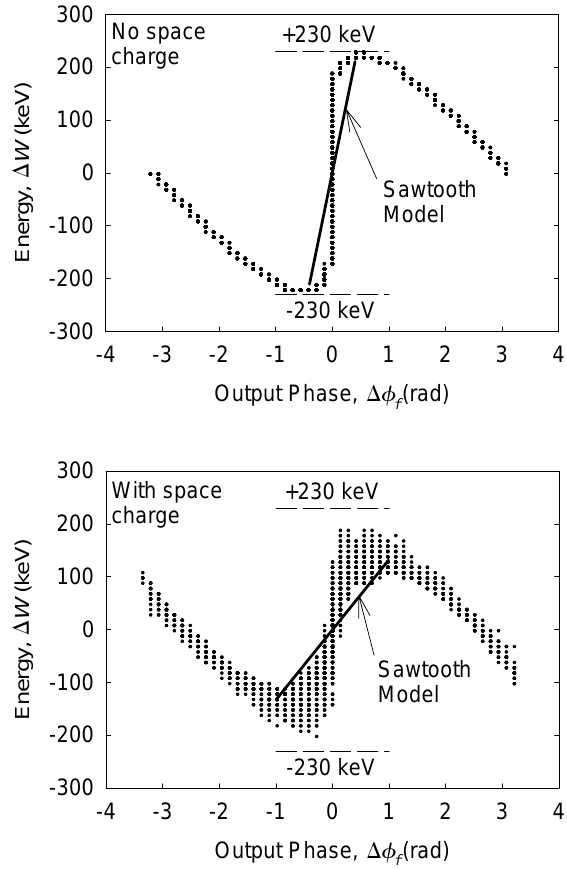
FIG. 4. Phase space diagrams for the analytic and PARMELA results. The initial energy modulation amplitude is Dg (cid:1) g (cid:1) 0.51% . Other parameters for the PARMELA computation are listed in Table IV. (a) No space charge effects, (b) with space charge effects.